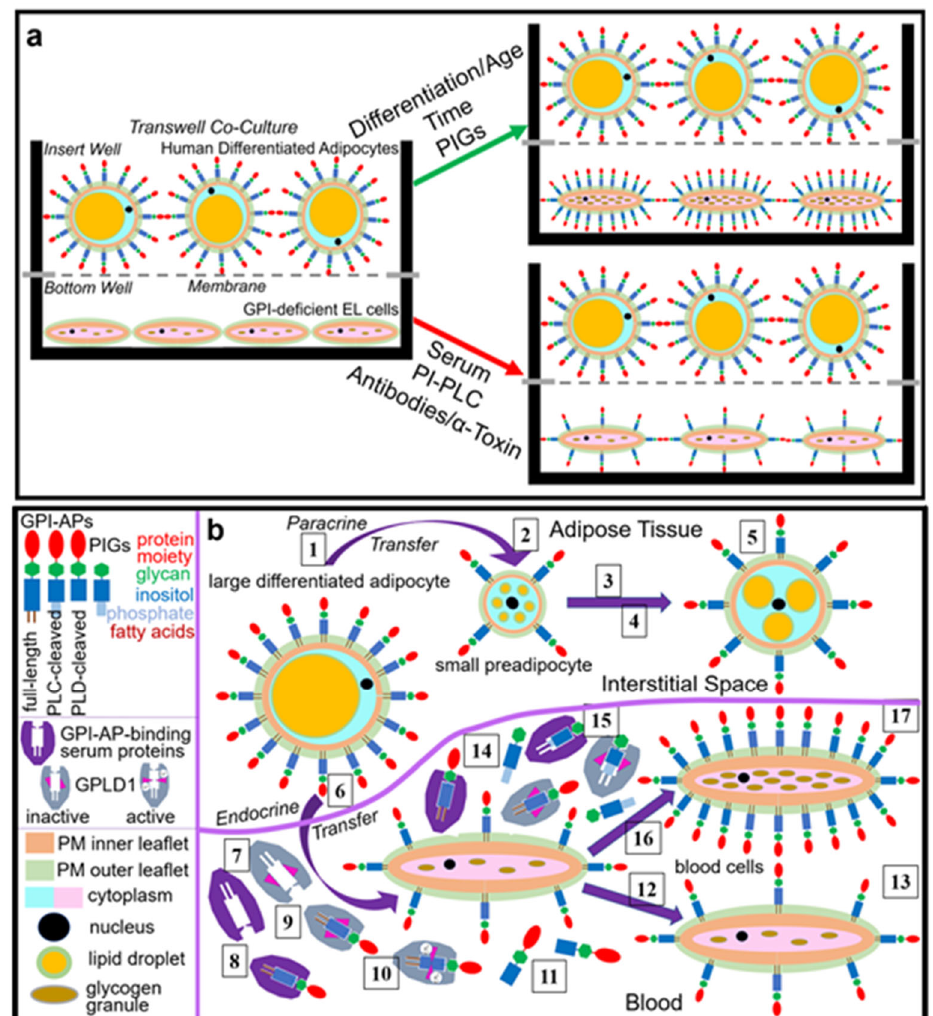
Figure 11. Intercellular transfer of GPI ‐ APs. ( a ) Analysis by transwell co ‐ culture as exemplified for the donor human adipocytes—acceptor EL cells configuration. (Left half) Human adipose ‐ derived stem cells (hADSCs) are seeded in the top insert well, which is equipped with a bottom porous filter plate and placed onto a companion bottom well, then grown to confluency and subsequently differentiated into human adipocytes of varying stage of lipid ‐ loading. GPI ‐ deficient EL cells are seeded in a separate bottom well and then grown to confluency. For initiation of transfer, the insert well harboring the human adipocytes is placed on top of the bottom well harboring the GPI ‐ deficient EL cells and then incubated for certain periods in the absence or presence of certain agents before measurement of GPI ‐ AP expression at PM (by chip ‐ based SAW sensing) and glycogen synthesis (by addition of U ‐ [ 14 C]glucose) by the EL cells in the bottom well (parallel wells for each incubation) after its disassembly from the companion insert well (see Materials and Methods for details). (Right upper half) Incubation of human adipocytes in the insert wells with GPI ‐ deficient EL cells in the bottom wells together with PIGs (in case of serum in the medium) leads to time ‐ dependent upregulation of the expression of GPI ‐ APs at PM of the EL cells with accompanying synthesis of glycogen and its accumulation in granules. (Right lower half) Transfer and synthesis were considerably diminished in the presence of antibody ‐ protein A against GPI ‐ APs or α‐ toxin, both coupled to Sepharose, bacterial PI ‐ PLC or serum in the medium (see [ b ] for explanation of the symbols). ( b ) Hypothetical model for the intercellular transfer of GPI ‐ APs via endocrine and paracrine routes and its impact on lipid and glycogen synthesis of adipose cells (upper compartment, stages 1–5) and blood cells (lower compartment, stages 6–16), respectively, in response to endogenous or exogenous cues. (Upper compartment) Paracrine transfer of full ‐ length GPI ‐ APs within adipose tissue depots is initiated by their release from the outer leaflet of the PM of large heavily lipid ‐ loaded adipocytes [1]. This may be facilitated by specific characteristics of the PM (e.g., viscoelasticity and stiffness), typical for the age and metabolic state of the donor cells as